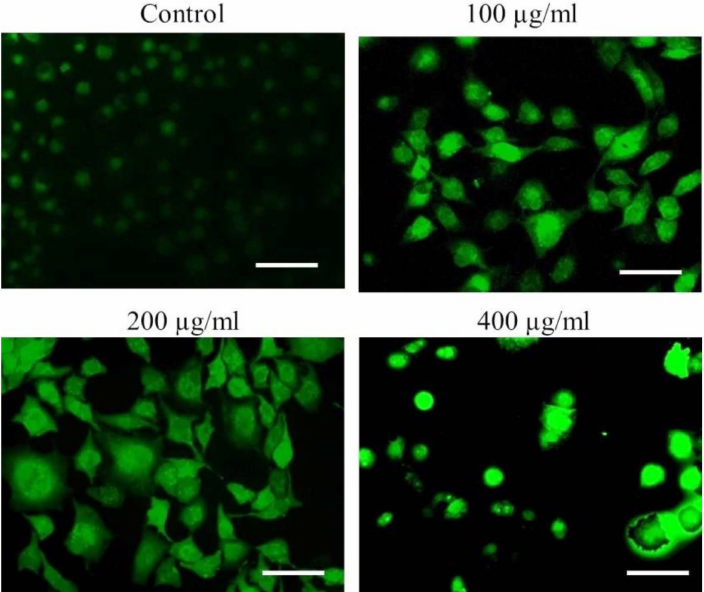
Figure 10. Qualitative assessment of ROS augmentation within AvL -EtOH-treated A549 cells. Fluores- cent photomicrographs indicating enhanced DCF florescence within A549 cells treated with varying concentrations of AvL -EtOH (100, 200 and 400 µ g/mL). Scale bar = 100 µ